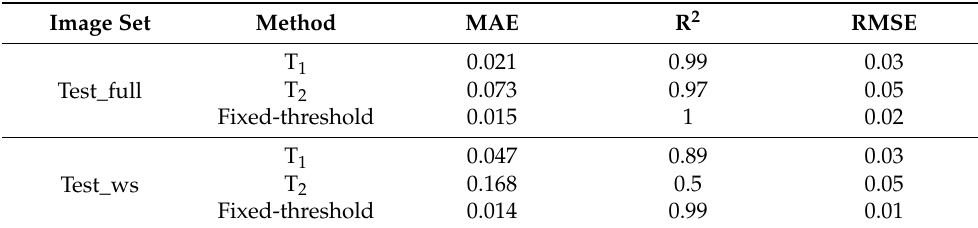
Table 5. Performance of FVC estimation using three methods on a*_I color feature.